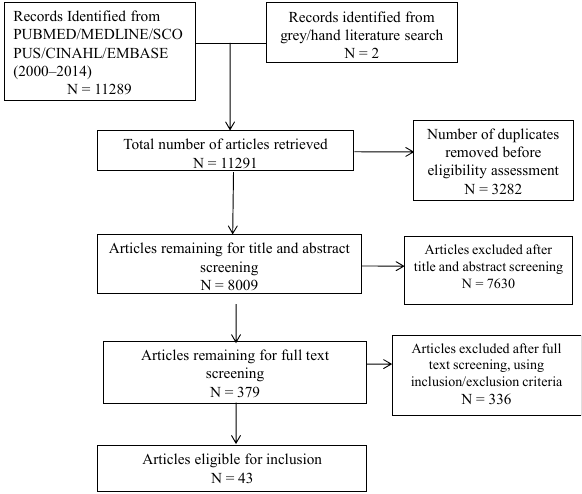
Figure 1. Study selection flowchart.